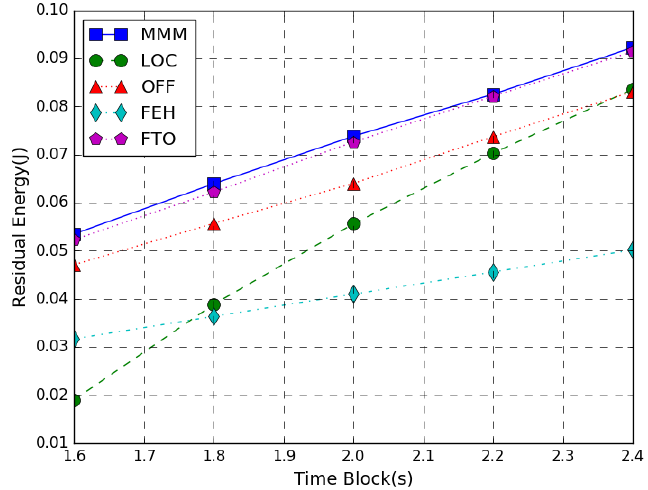
Figure 5. Time block vs. residual